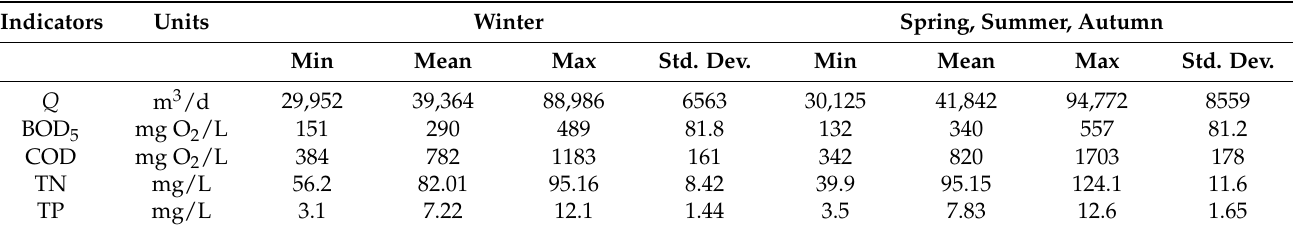
Table 1. Variation in the quantity and quality of selected wastewater quality indicators (BOD 5 , COD, TN, TP) at the analyzed wastewater treatment